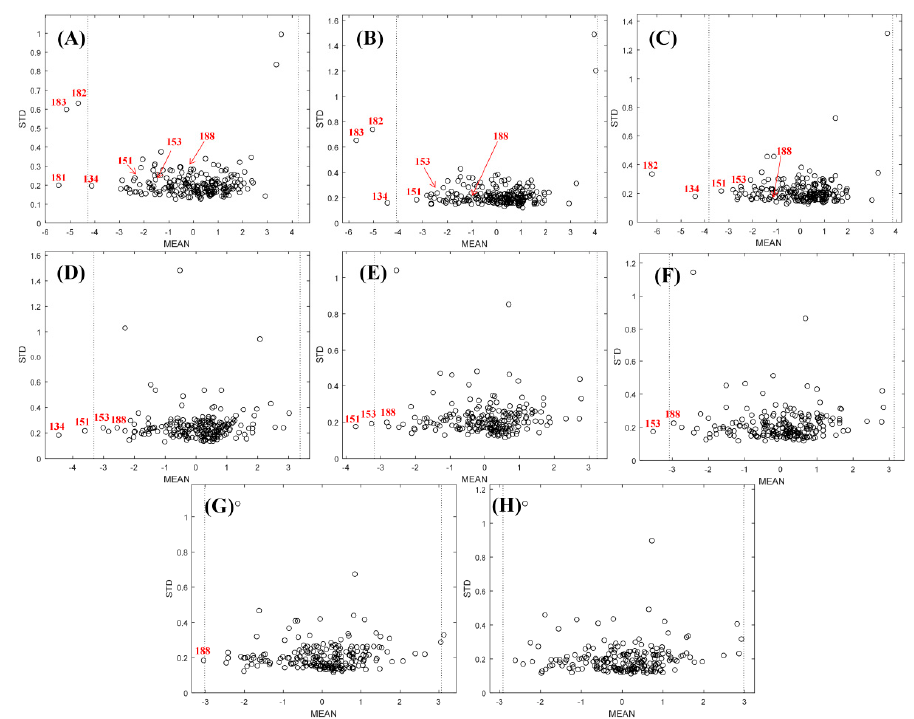
Figure 1. The process of model population analysis (MPA)-based outlier elimination on the FTC dataset of integrated descriptors. The dashed line is defined as the boundary for outliers, which is mean ± 3× standard deviation of prediction errors. ( A ) No outlier was eliminated, ( B ) sample No. 181 was eliminated, ( C ) sample No. 183 was eliminated, ( D ) sample No. 182 was eliminated, ( E ) sample No. 134 was eliminated, ( F ) sample No. 151 was eliminated, ( G ) sample No. 153 was eliminated, and ( H ) sample No. 188 was eliminated and all of the outliers were